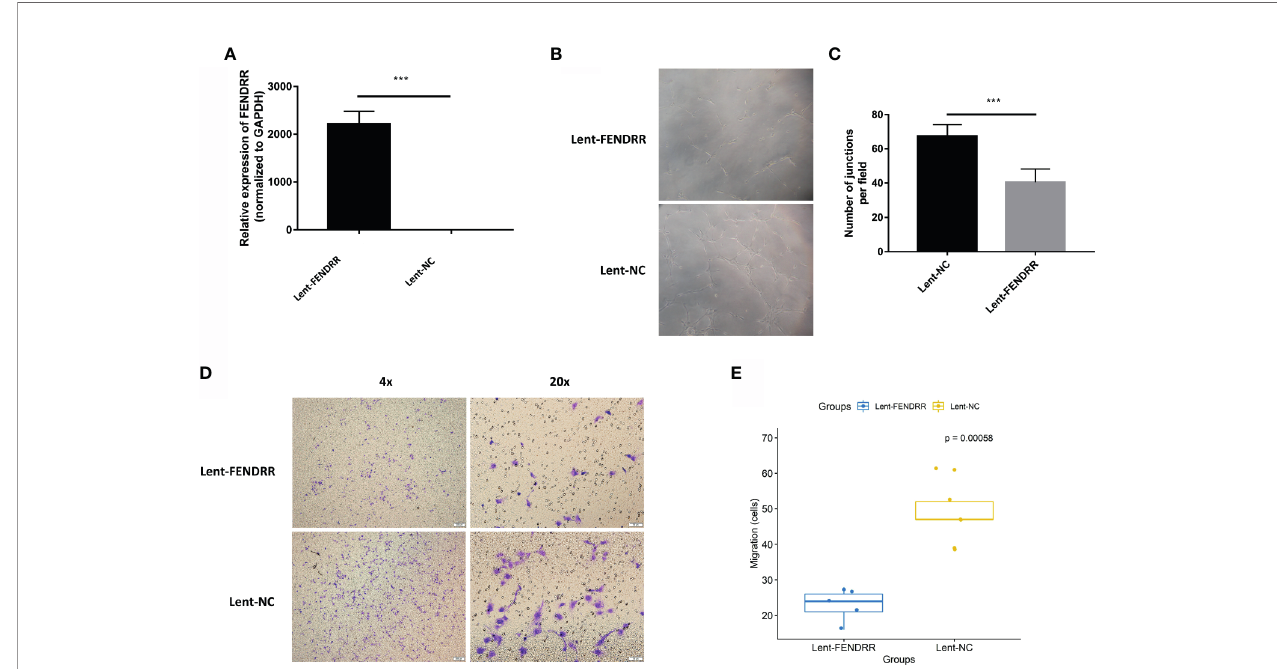
FIGURE 3 | FENDRR inhibits the proangiogenic effect of CAFs. (A) FENDRR was signi fi cantly overexpressed in CAFs transfected with lent-FENDRR. (B, C) The number of the capillary-like structure formed by HUVECs co-cultured with CAFs transfected with Lent-FENDRR was signi fi cantly reduced. (D, E) The migration assay showed that CAFs transfected with Lent-FENDRR could inhibit the migration ability of HUVECs. *** P < 0.001.